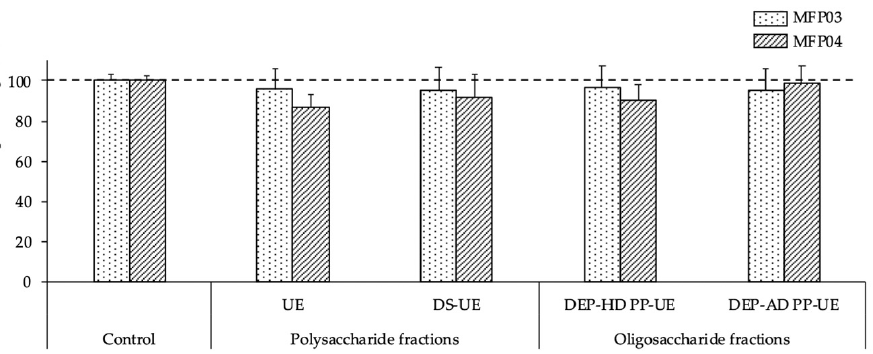
Figure 7. Effects of poly- and oligosaccharide Ulva sp. fractions at 1000 µ g/mL on the cytotoxic potential of S. aureus MFP03 ( n = 3) and S. epidermidis MFP04 ( n = 3) towards HaCaT keratinocytes evaluated by LDH (lactate dehydrogenase assay). No statistically significant differences were observed in comparison to the